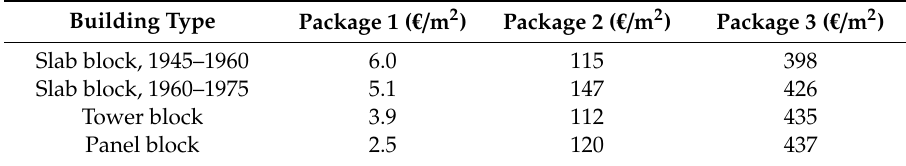
Table 3. Marginal costs for each building type and energy retrofitting package according to the reference study